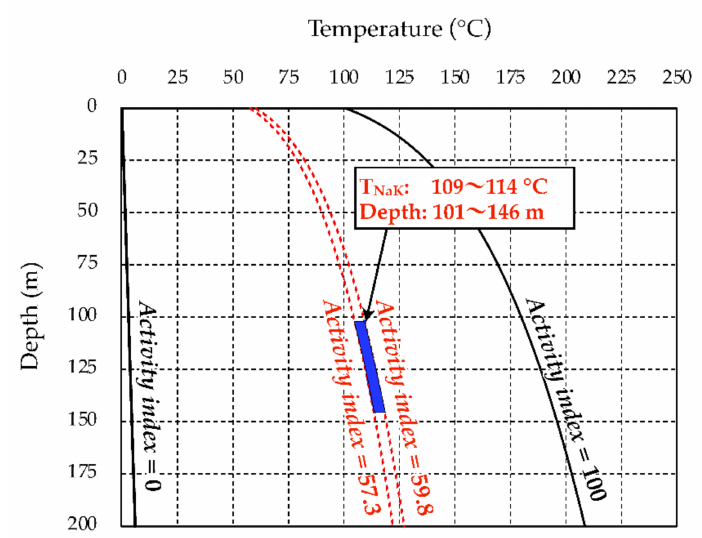
Figure 8. Thermal profile estimated from the activity index of the Futamata hot spring. The thermal profile was estimated from data with the minimum and maximum activity indexes and drawn with a red, dotted line. The blue area shows the depth at which the presence of the aquifer was estimated from the activity index and Na–K temperature. The solid, black line shows a curve with an activity index of 100 and a straight line with 0,